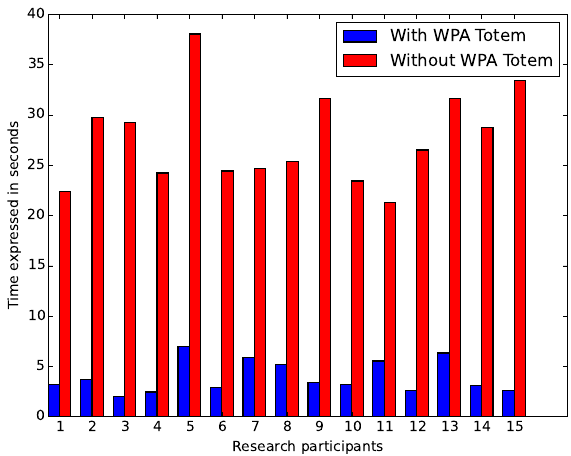
Figure 4. Wi-Fi configuration time with and without